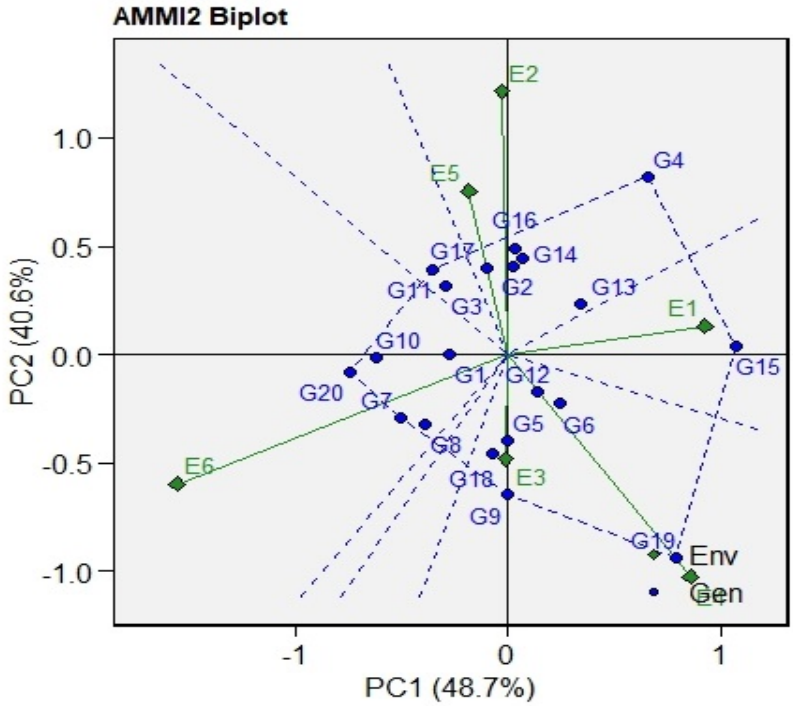
Figure 4. AMMI2 Biplot (IPC1 vs. IPC2) for grain yield (t/ha) of 20 wheat genotypes evaluated across six environments. The genotype (G) code is indicated according to Table 6.